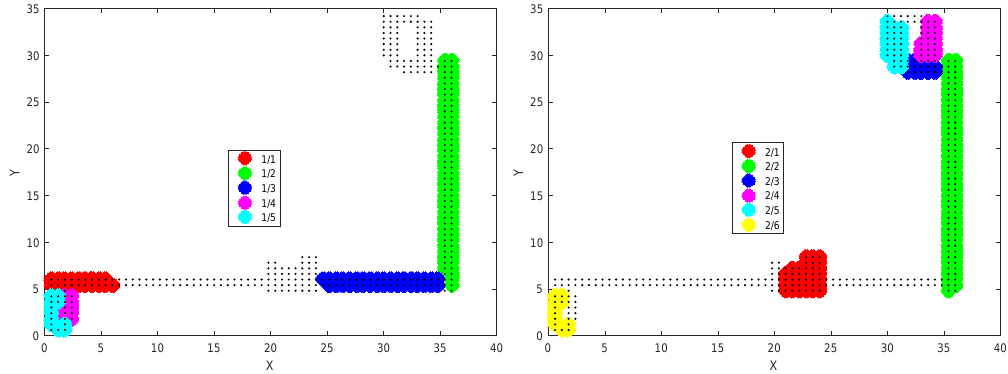
Figure 13. The Pisa traces from Campaign 1 ( lef t) and Campaign 2 ( right